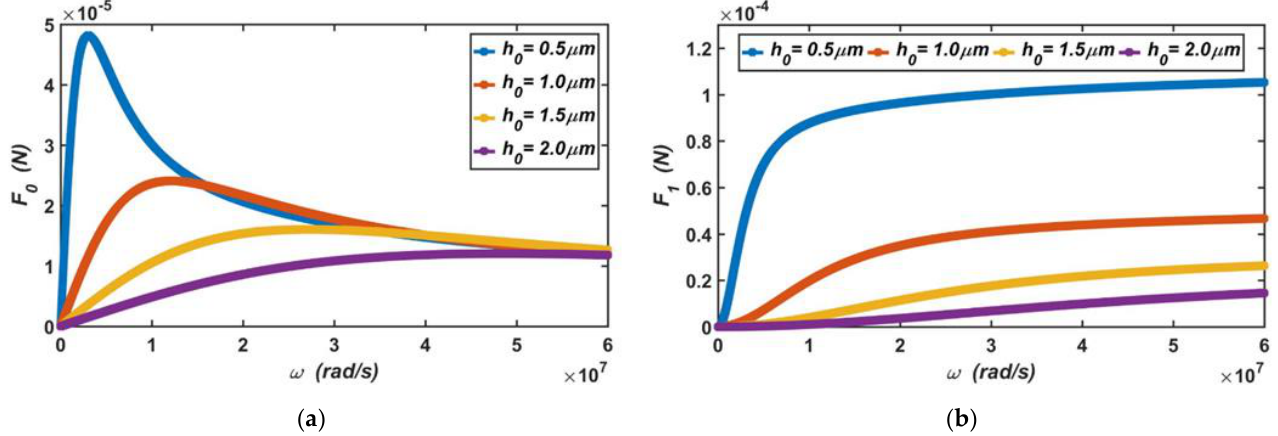
Figure 7. ( a ) The dependence of the viscous damping force on the vibration frequency of the moving plate, and ( b ) the dependence of the elastic damping force on the vibration frequency of the moving plate when the gap between the movable electrode plate and fixed electrode plate ranges from 0.5 to 2 µm.